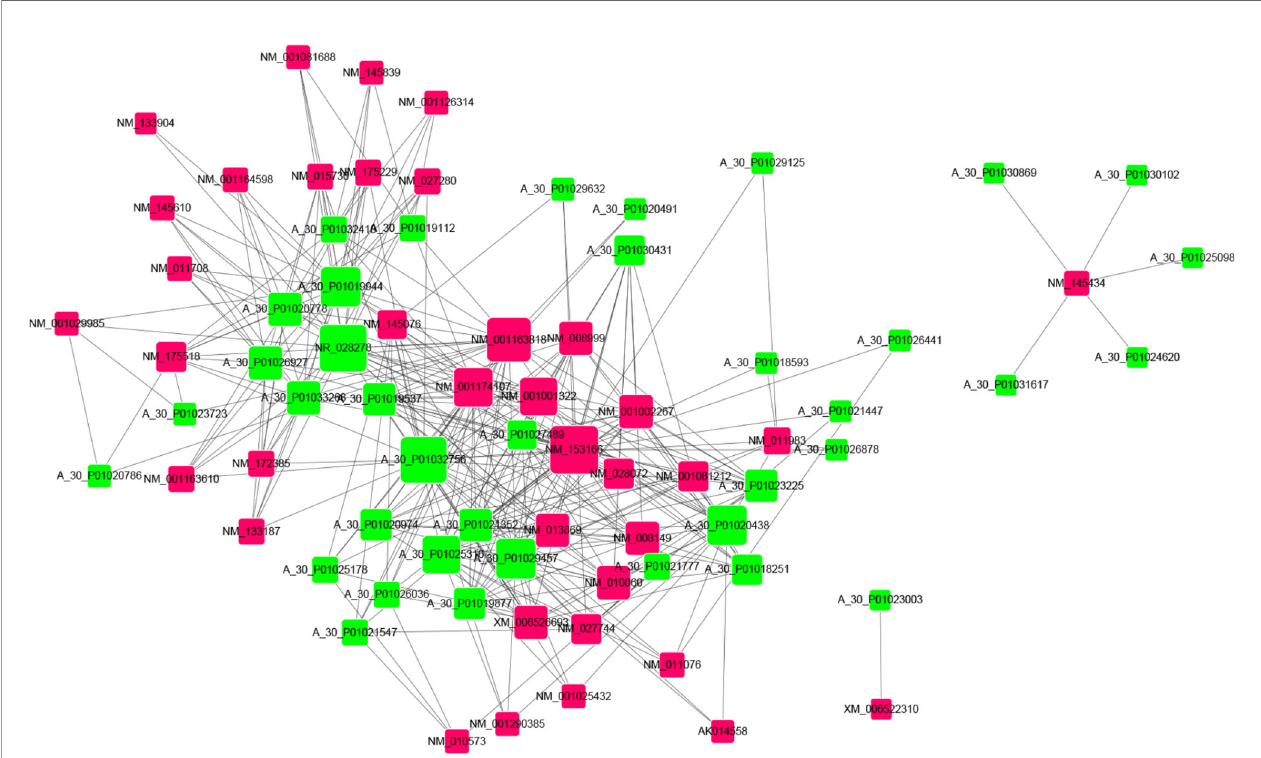
FIGURE 5 | CeRNA network of the differentially expressed lncRNAs with their associate mRNAs. Co-expression lncRNA – mRNA pairs were identi fi ed using strict screening criteria (correlation coef fi cient ≥ 0.90 and p ≤ 0.01). Different colors were used to show different genes, with green for lncRNAs and red for